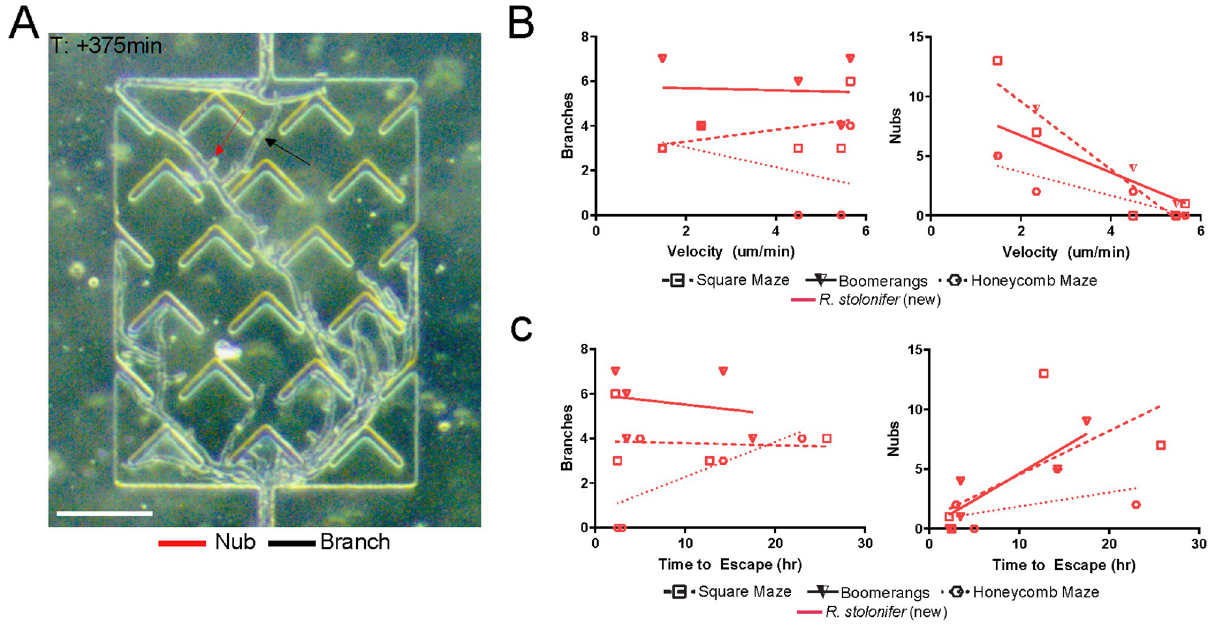
Fig 7. Branching and nubbing of growing R . stolonifer hyphae. R . stolonifer displayed a unique phenotype during hyphal growth, sometimes forming fully developed branches, other times creating small branches that did not grow further, termed "nubs" here (see methods for full criteria). (A) A full branch and a hyphal nub are identified in the image. Scale bar is 100 μ m. (B) We found that the number of branches on each hypha is independent of the hyphal velocity. The number of nubs increases with decreasing hyphal velocity. (C) We found no relationship between the time to escape and the number of branches and